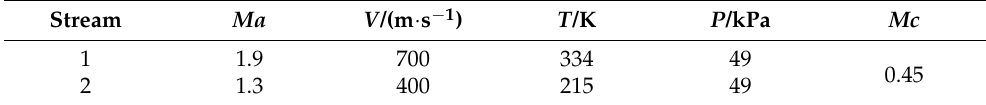
Table 3. Incoming condition of Geobel – Dutton experiment.